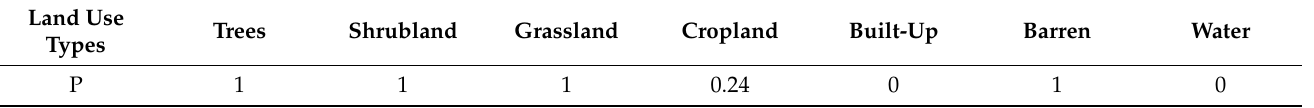
Table 2. P-values of different land use types.